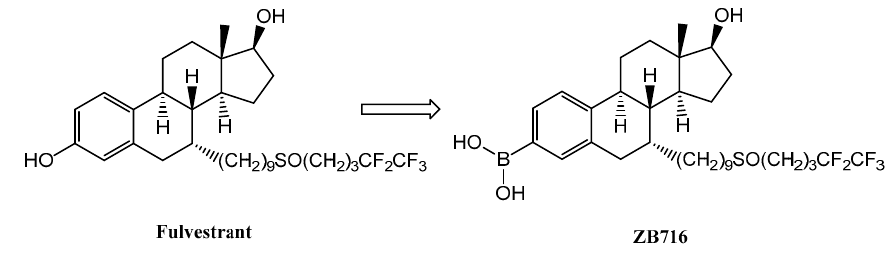
Figure 1. Structure of fulvestrant and